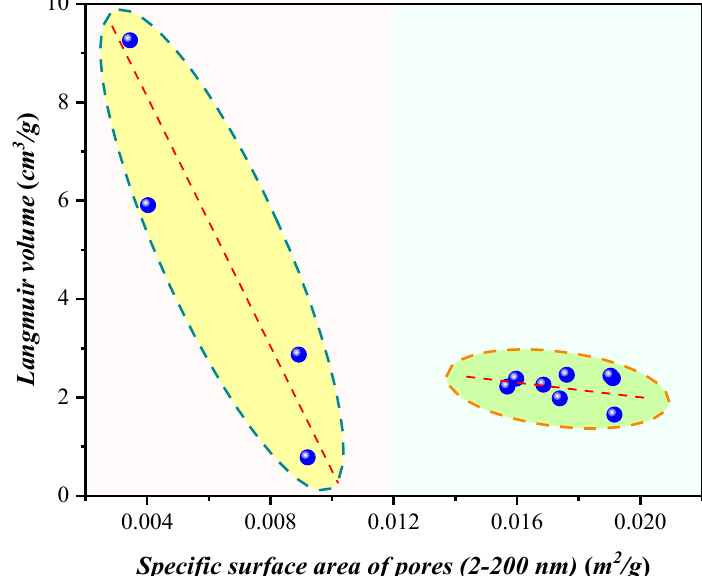
Figure 15. Relationship between methane adsorption capacity and specific surface area of pores (2–200 nm) for the 12 shale samples by the low-temperature nitrogen adsorption experiment.